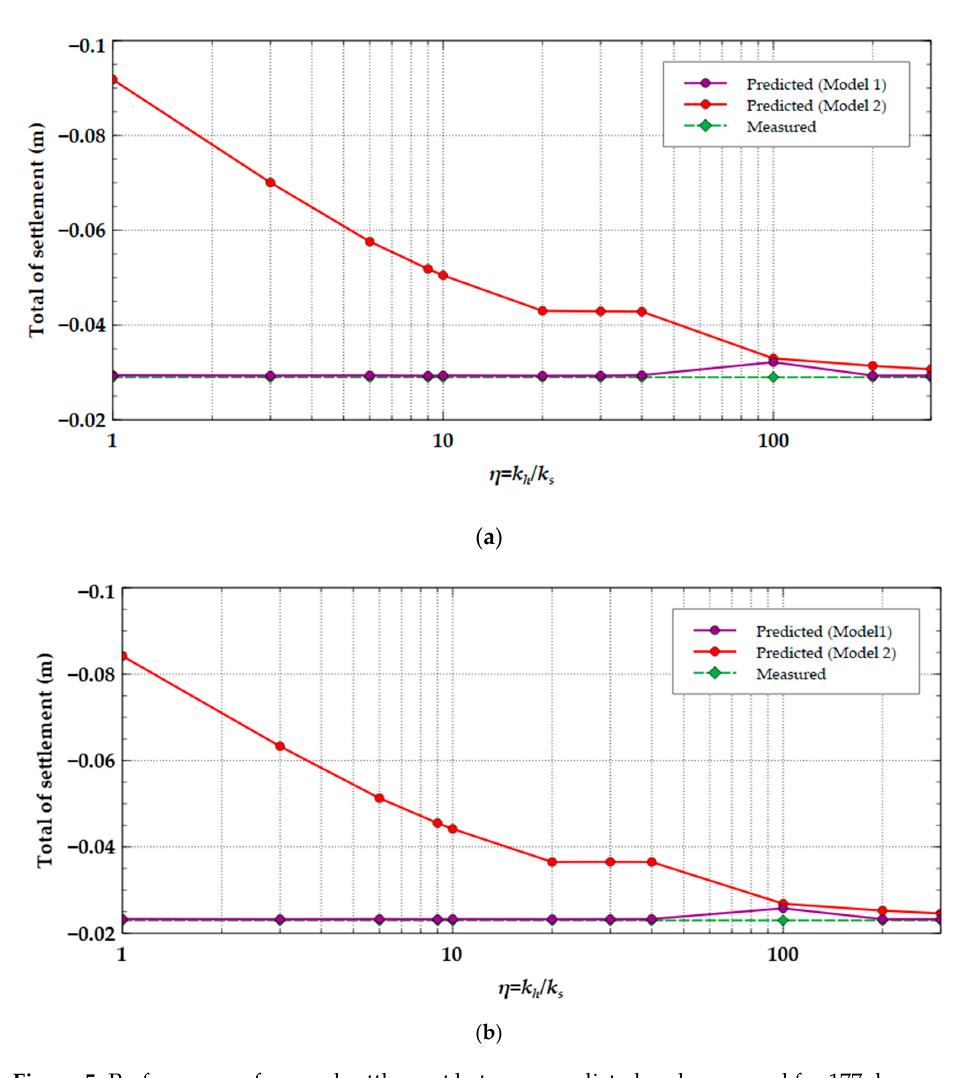
Figure 5. Performance of ground settlement between predicted and measured for 177 days consoli- dated: ( a ) SM1; ( b ) SM2. dated: ( a ) SM1; ( b )